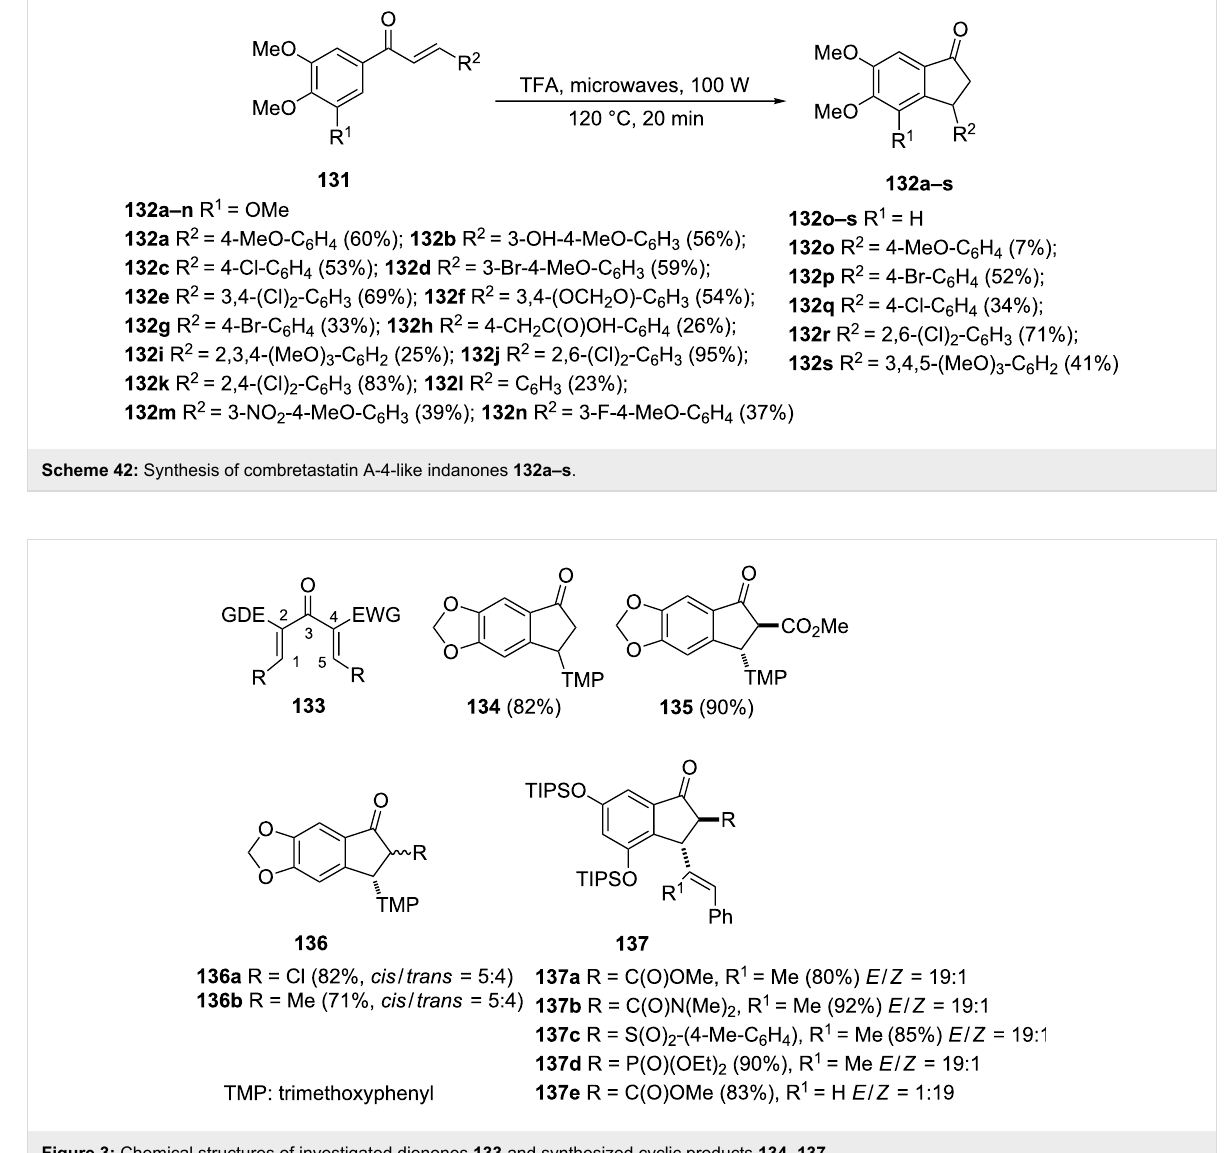
Figure 3: Chemical structures of investigated dienones 133 and synthesized cyclic products 134–137 .